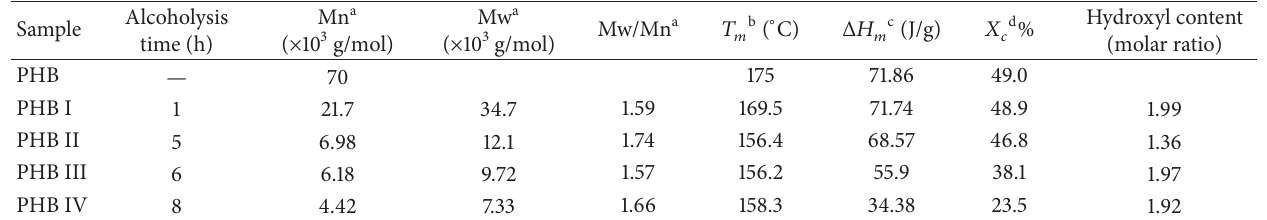
Table 1: Reaction conditions, thermal and molecular weight characteristics of